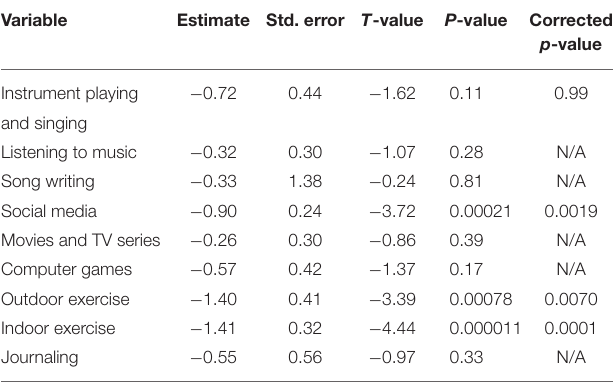
TABLE 3 | The effect of students’ ratings of how effective key activities were on their well-being as predictors of STAI–S scores (corrected p -values use Bonferroni correction for the 9 models